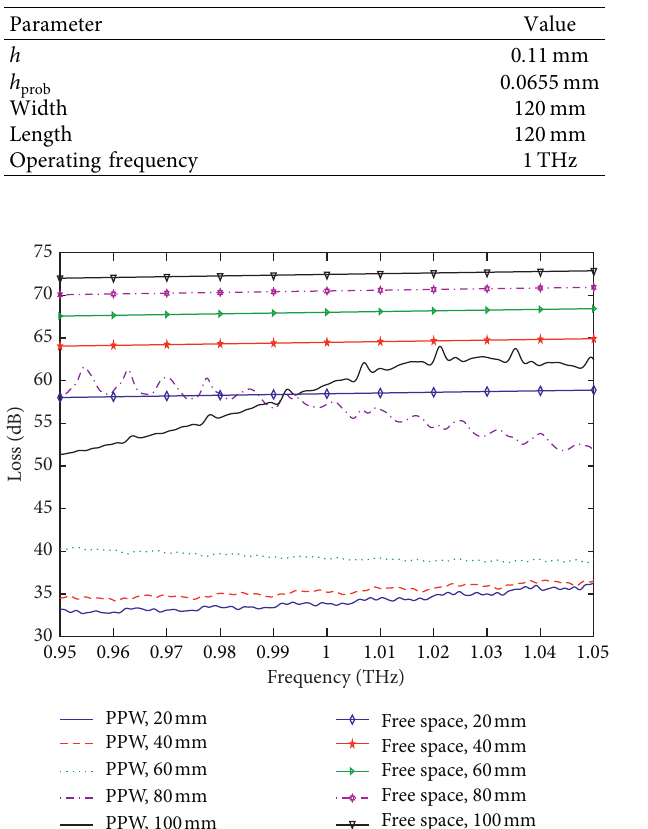
Figure 8: The proposed PPW as a low-loss wireless channel for communicating between the gateways (interchip communication). Red, yellow, and green rectangulars indicate the chip gateways, wireless nodes, and nonwireless nodes, respectively. Table 1: The physical and operating parameters of the proposed parallel-plate waveguide.